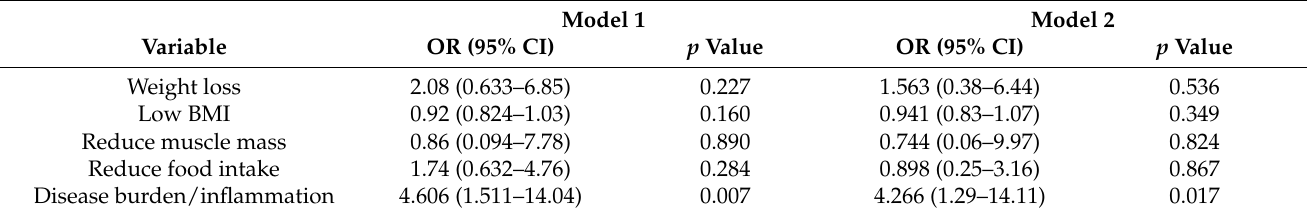
Table 7. Binary logistic regression for the association between GLIM criteria and the prevalence of macrovascular complications.